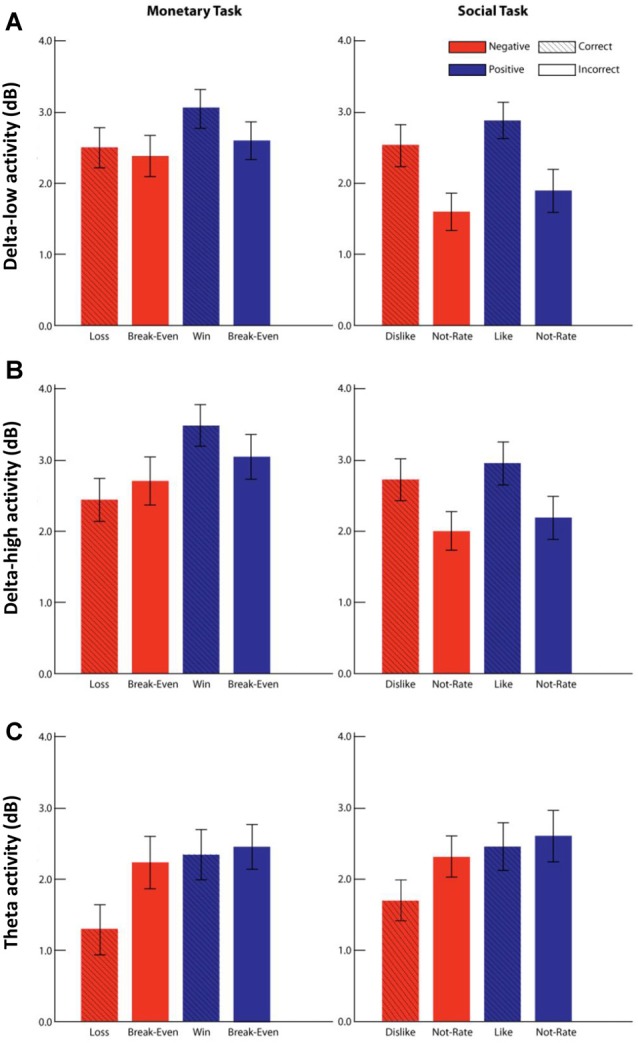
Delta and theta activity during the monetary and social tasks. Panels (A–C) represent the results for each factor: delta-low (TF1SF1; A), delta-high (TF2SF2; B), and theta (TF4SF1; C). Mean activity for each factor in each condition is shown for monetary (left column) and social (right column) tasks. Error bars represents ± 95% confidence interval. Negative valence is represented in red, and positive valence is represented blue. Correct and incorrect outcomes are differentiated by presence and absence of the line pattern.